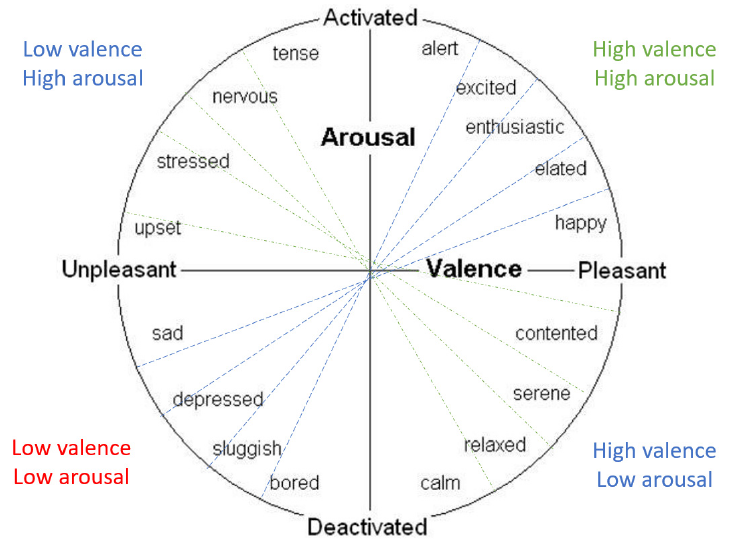
Figure 11. Circumplex Model. Source: [51].